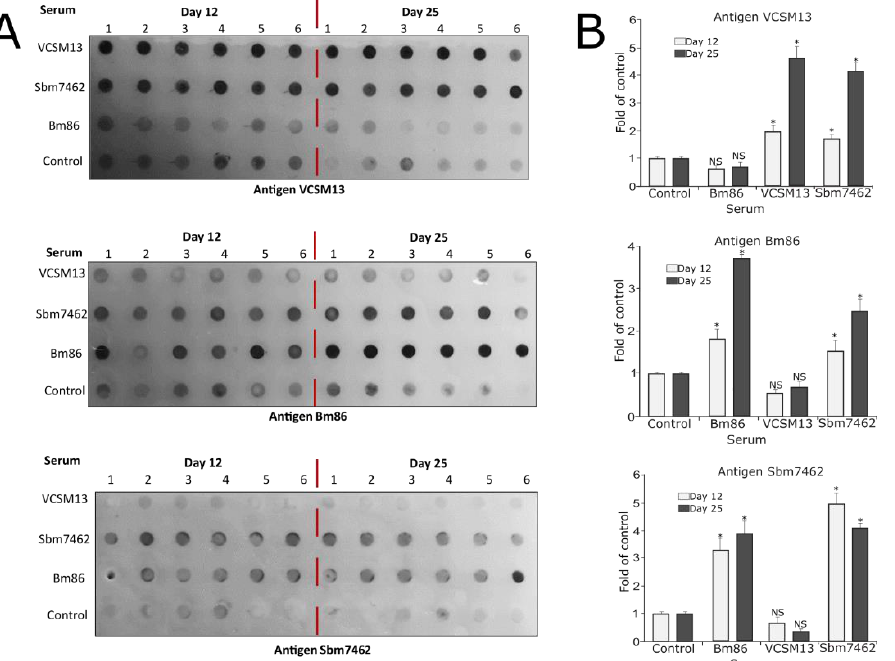
Figure 7. Antibody response. ( A ) . Dot blots of the antibody evaluation from mice serum obtained by day 12 and day 25. Serum samples from all mice were tested with individual membranes coated with the respective antigens. Mice were inoculated subcutaneously with PBS (control group), 1 × 10 12 PFU VCSM13 (control phage), 5 µg commercial antigen BM86, and 1 × 10 12 PFU Sbm7462-phage vaccine equivalent to 5 µg antigen. All treatments were administered in 100 µL of PBS. ( B ) . Densitometry analysis of the dot blots. n = 6. * p -value < 0.05 compared to control group, NS — not significant.